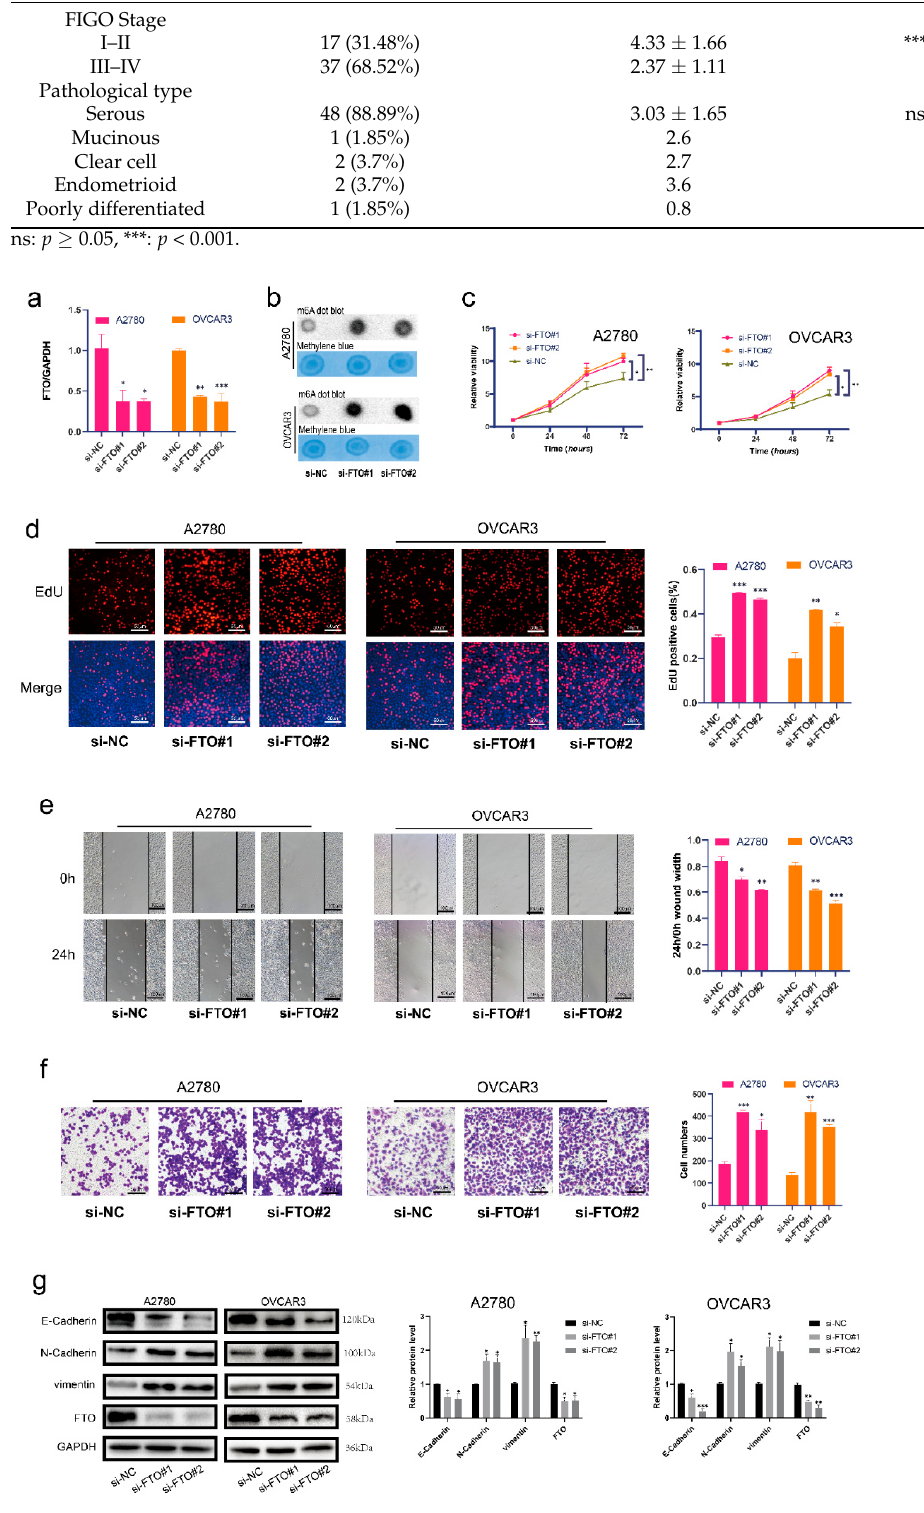
Figure 2. FTO knockdown promoted malignant phenotypes of EOC cells in vitro. ( a ) RT-qPCR validation of FTO knockdown in A2780 and OVCAR3 cells. ( b ) m6A levels of EOC cells were detected by m6A dot blot after FTO knockdown. ( c ) CCK-8 assays detected cell viability after FTO knock- down. ( d ) EdU assay detected the proliferation of EOC cells. Scale bar, 50 μ m. ( e ) Wound healing assays detected cell migration after FTO knockdown. Scale bar, 100 μ m. ( f ) Transwell assay tested the invasion of ovarian cancer cells. Scale bar, 50 μ m. ( g ) Expression of EMT-related markers, N- cadherin, E-cadherin, and vimentin in FTO knockdown A2780 and OVCAR3 cells determined by Western blotting. The data represent the results of three independent replicates. Data are presented as mean ± SD; * p < 0.05; ** p < 0.01; *** p < 0.001. The uncropped blots are shown in Supplementary Material file S1